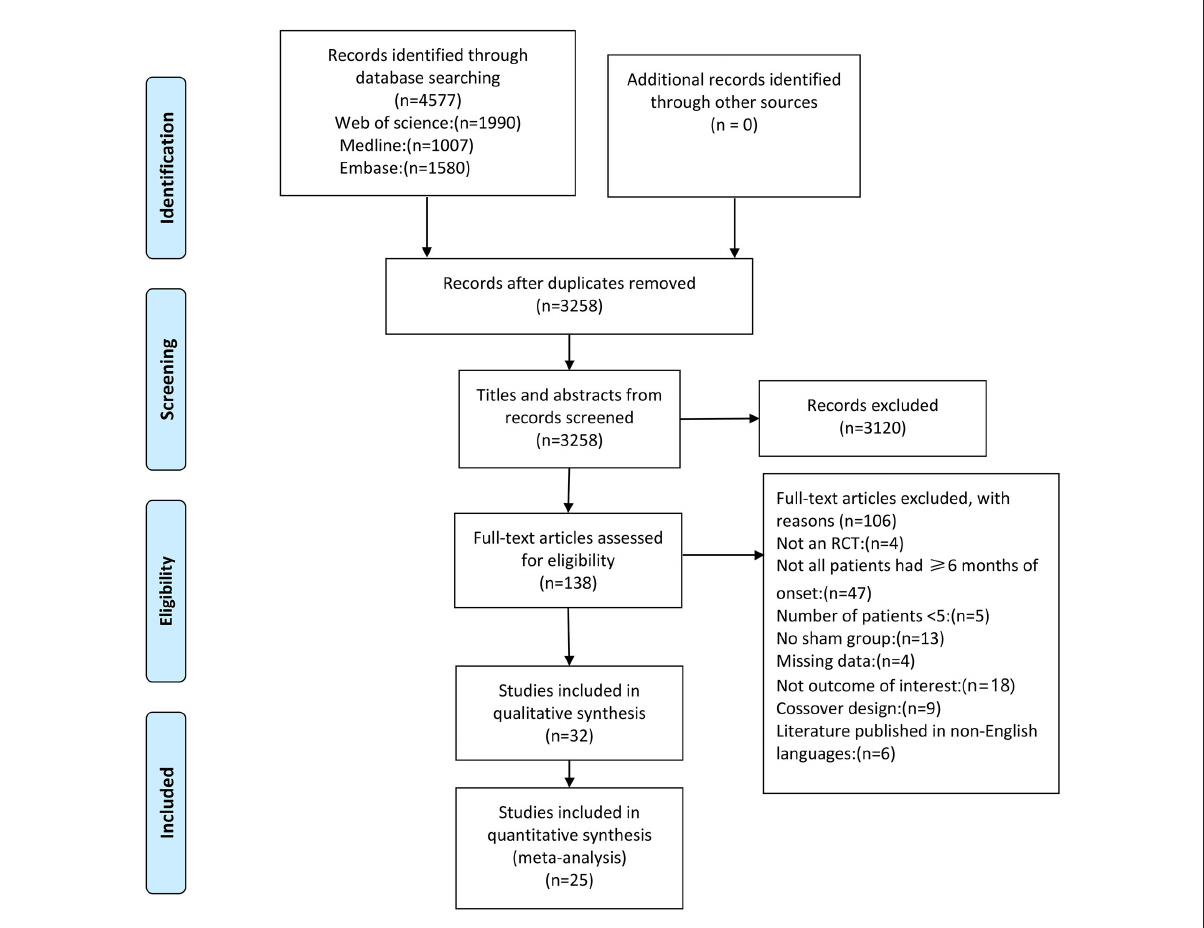
FIGURE1 PRISMA flow chart on the selection and inclusion of